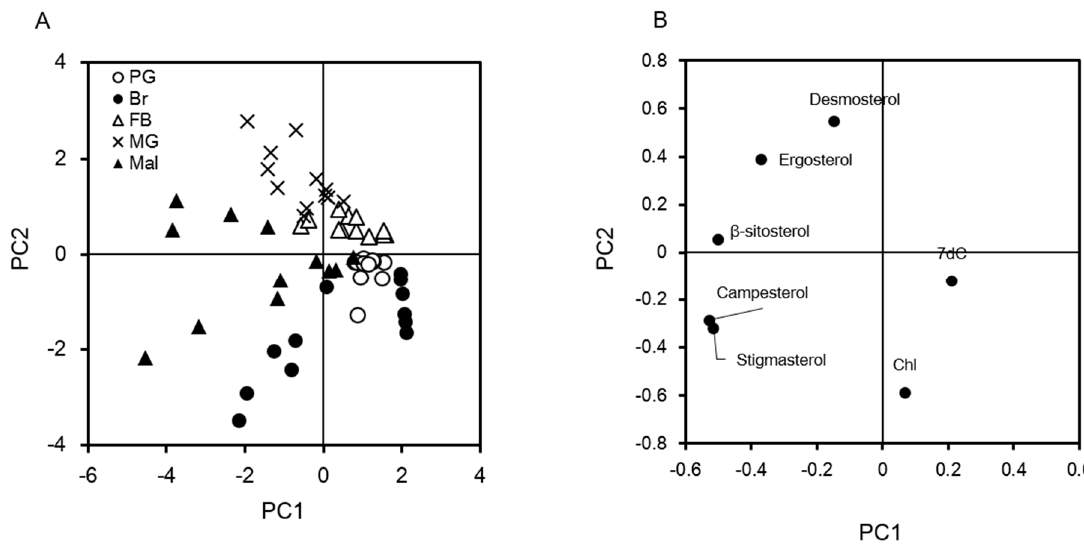
Figure 7. Characterization of insect tissues by steroid profiles using principal component analysis (PCA). The averages of dietary sterols, desmosterol, Chl, and 7dC in respective tissues (Figures 2, 5, 6, and Figures S3A, S3C, S6, S7) were analyzed by PCA, and are shown in a score plot ( A ) and loading plot ( B ). Score plot represents the characterization of tissues in respective stages determined by sterol profiles. Loading plot represents the characteristics of sterols extracted from the data. The vertical axis is the first principal component and the horizontal axis is the second principal component.